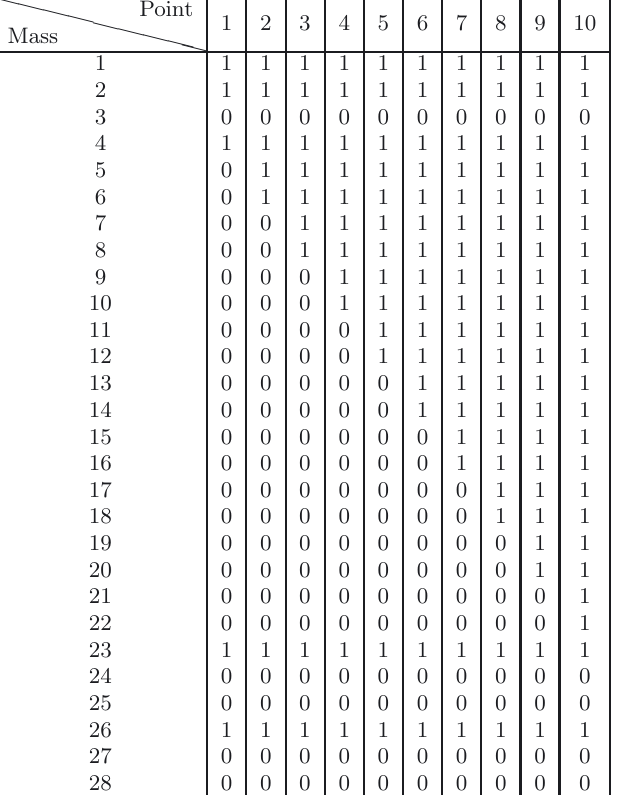
Table 4. Boolean values of utilized transfer standard mass pieces used for cross-floated pressures where mass piece #1 and mass piece #2 correspond to the piston and bell masses respectively, and points 1 through 10 correspond to the cross- floated pressures from 50 MPa to 500 MPa